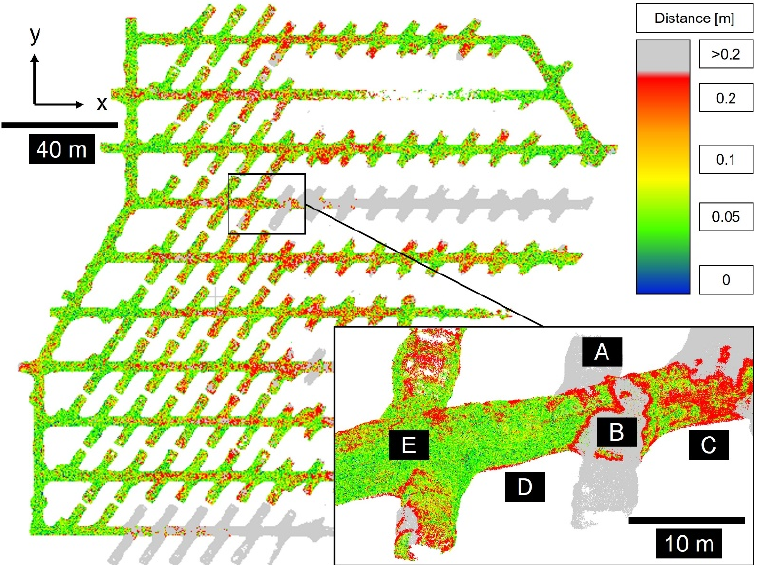
Figure 1. Example of color-coded lidar data of mine-wide changes by absolute distances. A : Miss- ing data, B : Transition from missing data to available data, C : Partial coverage between two scans, data, ( B ): Transition from missing data to available data, ( C ): Partial coverage between two scans, D : Changes in drift fl oor, E : Potential false positives in drift roof. ( D ): Changes in drift floor, ( E ): Potential false positives in drift